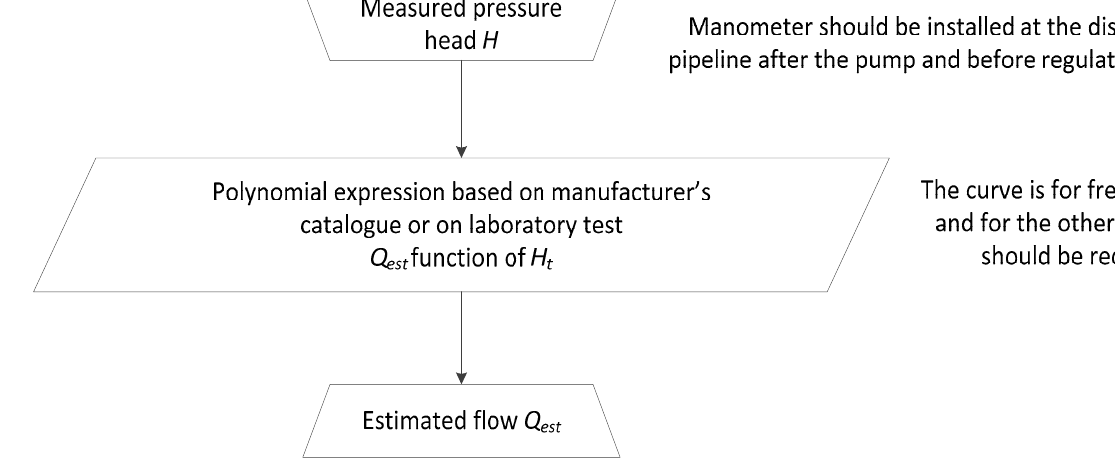
Figure 3. A simple algorithm for estimation of discharge flow.